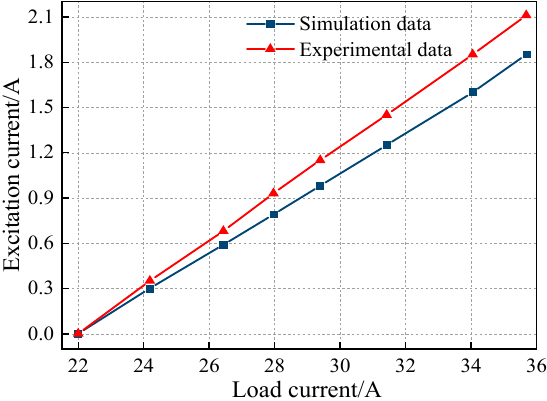
Figure 28. The compound excitation generator regulates the characteristic curve.